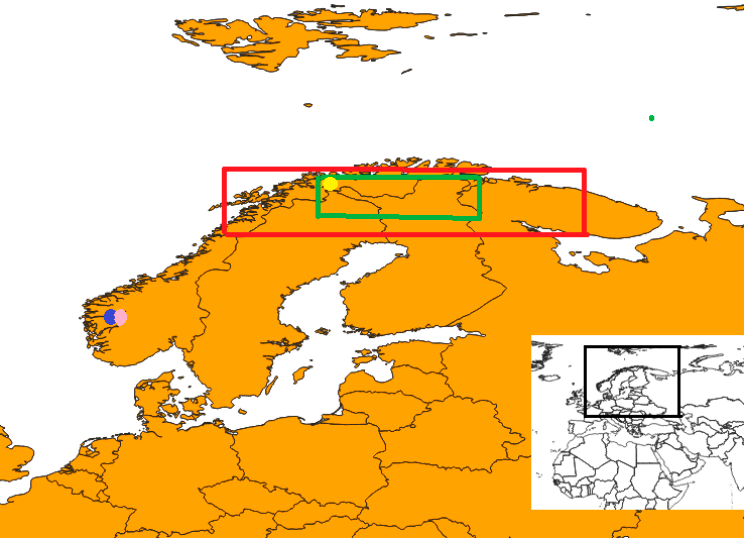
Figure 2. Location of glaciers and sampling areas of paleoproxies in Fennoscandia. Pollen data from 11 lakes, plus July pollen/tree-ring data for the past 7500 years [23] have been obtained in the red rectangle. Maximum latewood density of subfossil and modern tree rings data for the past 2000 years [22] have been obtained in the green rectangle. Western Norway glacial lake sediment data used to reconstruct ELA [24] have been obtained from the lakes Dravladalsvatn (blue circle) and Vassdalsvatn (pink circle). Sediment data from Aspvatnet glacial lake [25], Lyngen Peninsula, have been obtained in the yellow circle.